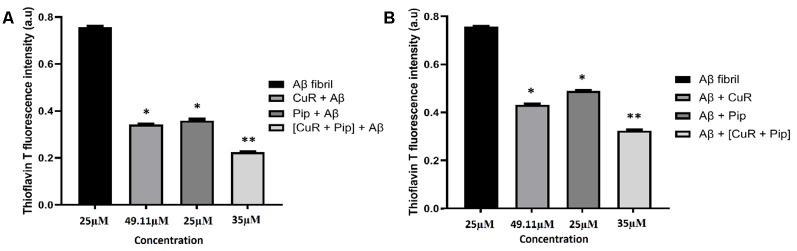
Thioflavin T (ThT) fluorescence assay of SH-SY5Y cells treated with Aβ, Donepezil + Aβ, curcumin + Aβ (CuR + Aβ), piperine + AB (Pip + Aβ), and combined curcumin and piperine + AB [(CuR + Pip) + Aβ] on (A) inhibition and (B) disaggregation of preformed Aβ fibrils (n = 3, *p < 0.05, **p < 0.01 compared to the Aβ group, one-way ANOVA followed by Tukey’s test).